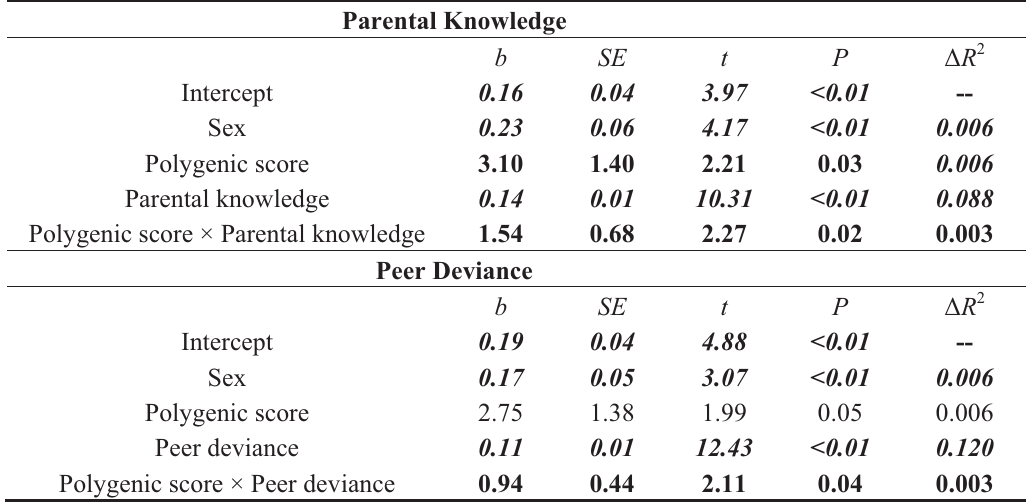
Polygenic score × Peer deviance 0.94 Boldfaced statistics indicate p < 0.05. Boldfaced and italicized statistics indicate p < 0.01. Abbreviations: n = sample size, b , unstandardized regression estimates; SE , standard error for b ; t , t -statistic; P , p